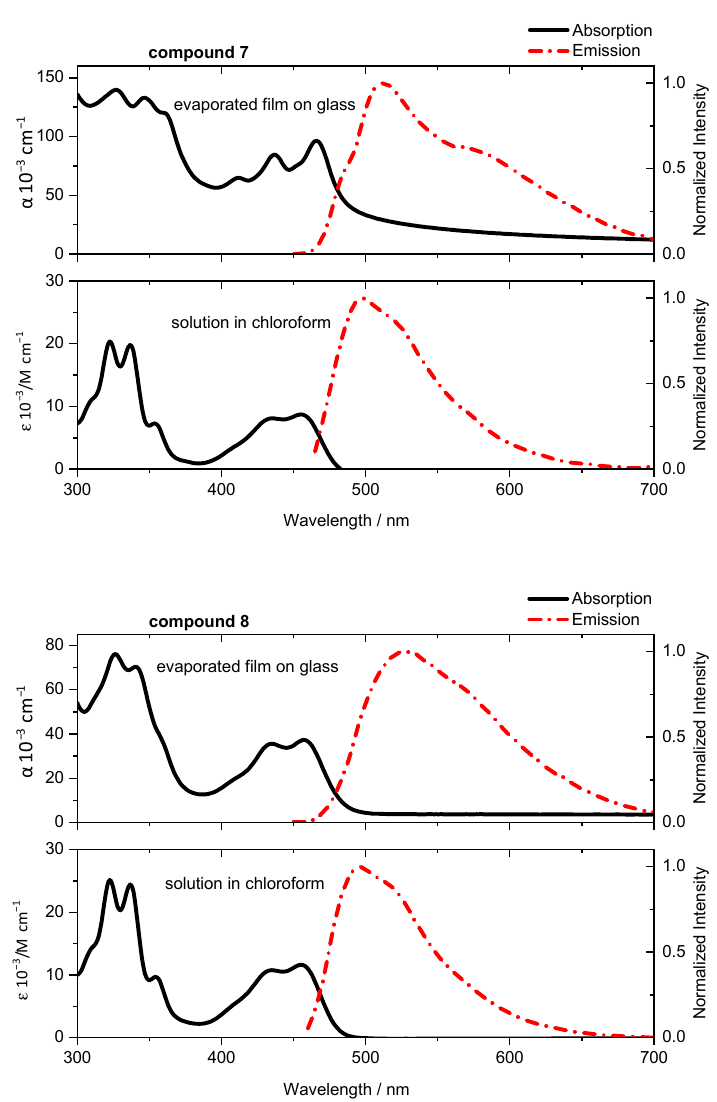
Figure 2. UV − Vis absorption and photoluminescence spectra of the compounds 1 – 8 .